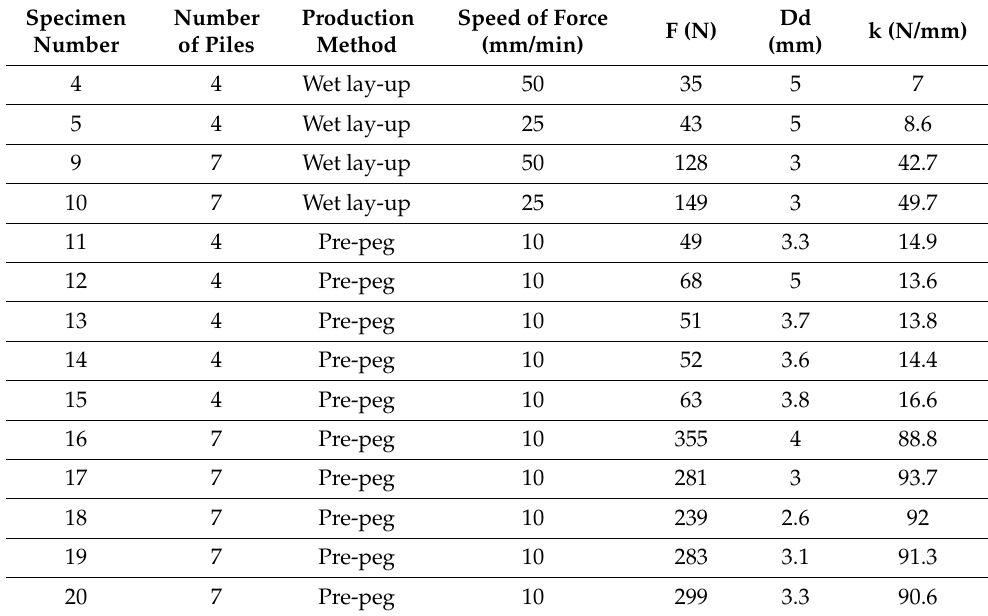
Table 2. CF specimen’s characteristics, production methods and calculated values of flexural strength.